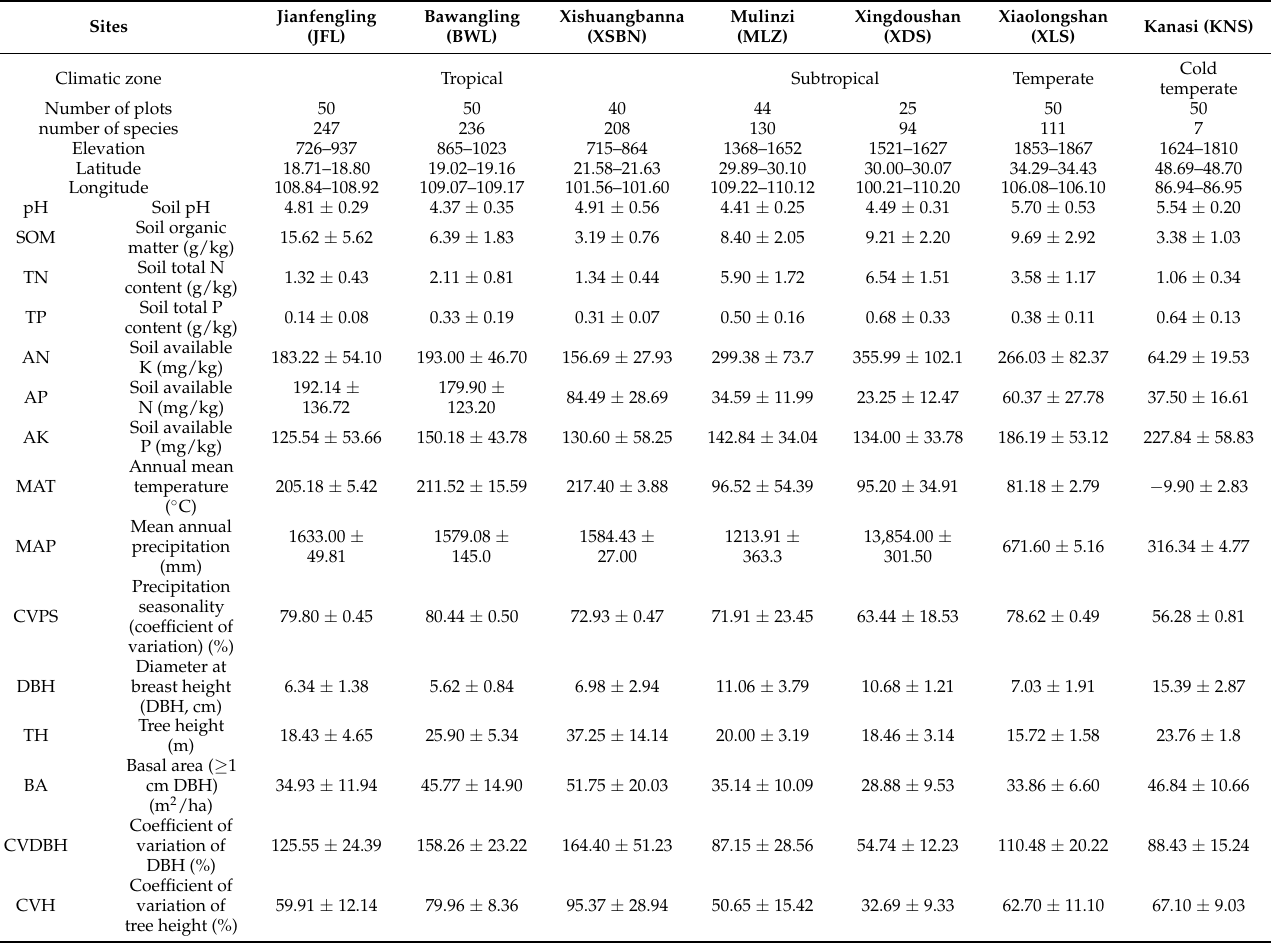
Table 1. Geographic, sampling, biodiversity, climate, and tree size information of forest plots across four climatic zones in